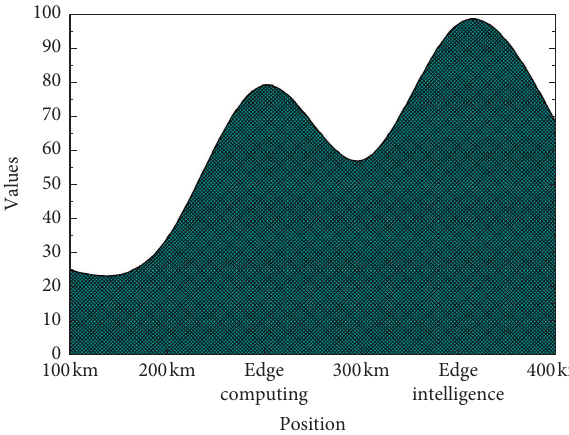
Figure 4: Diagram of data processing cost reduction (%)